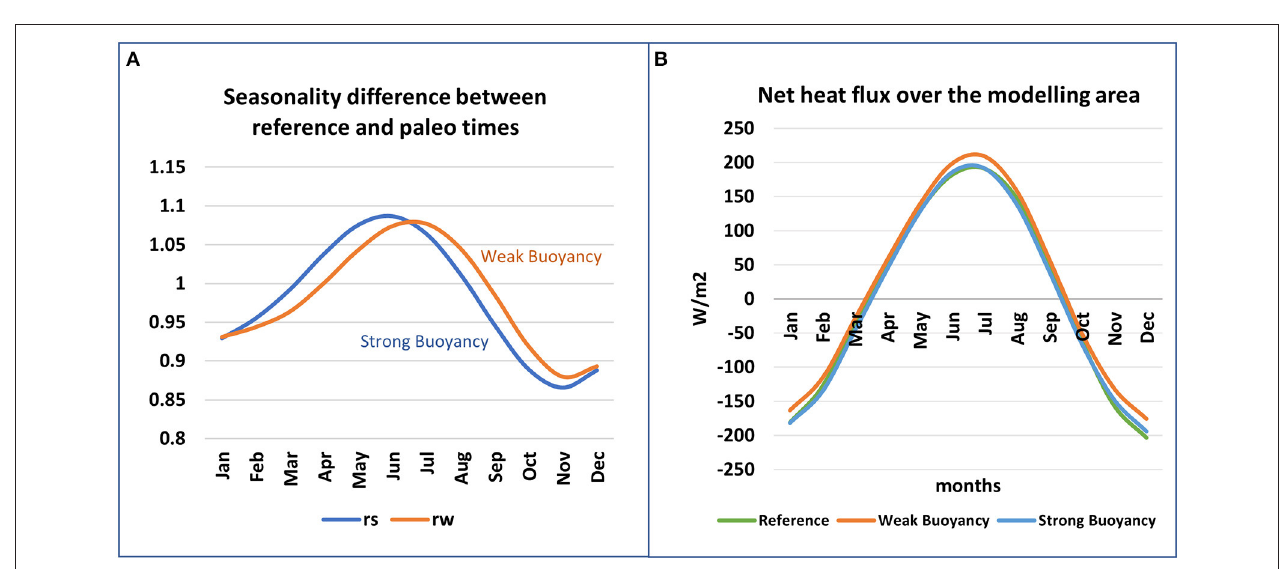
FIGURE 3 | (A) The term r gives the ratio of monthly average insolation at 38 ◦ latitude in 12 and 9.1 ky BP to the corresponding insolation during the instrumental period, (B) the net heat flux with the applied diagnosed fluxes for each experiment. The green line corresponds to the reference period, the blue to strong